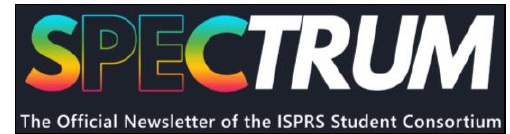
Figure 4. The design for SpeCtrum: The Official Newsletter of the ISPRS Student Consortium